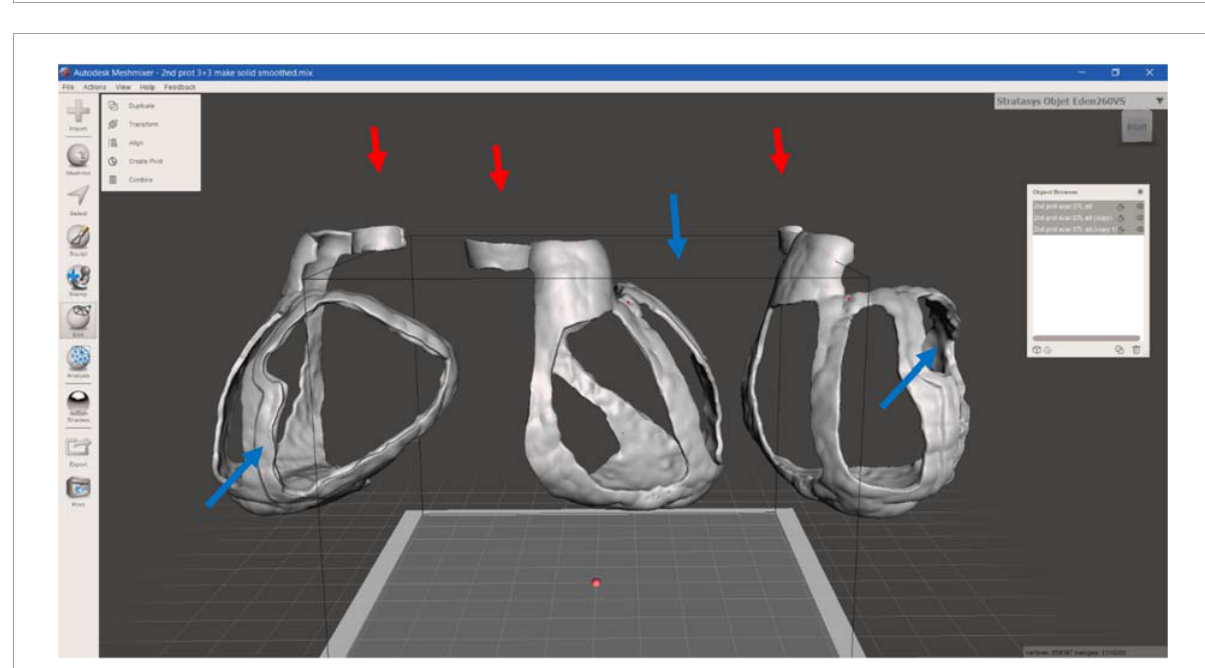
FIGURE6 3D surgical guide model. Anterior, lateral, and posterior view of the virtual surgical guide model: the blue arrows indicate the thicker border for the target (scar) identification, the red ones the reference point for aorta.